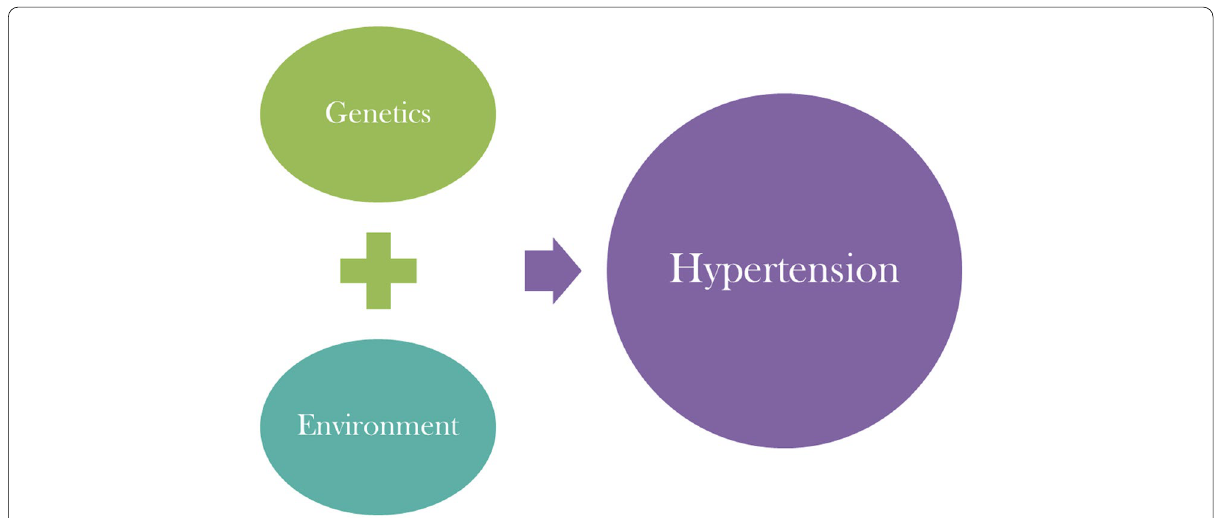
Fig. 1 Gene-environment interaction for phenotypic manifestation of hypertension